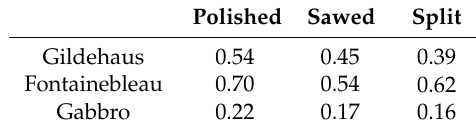
Table 2. Reflectance maxima of DHR spectra.